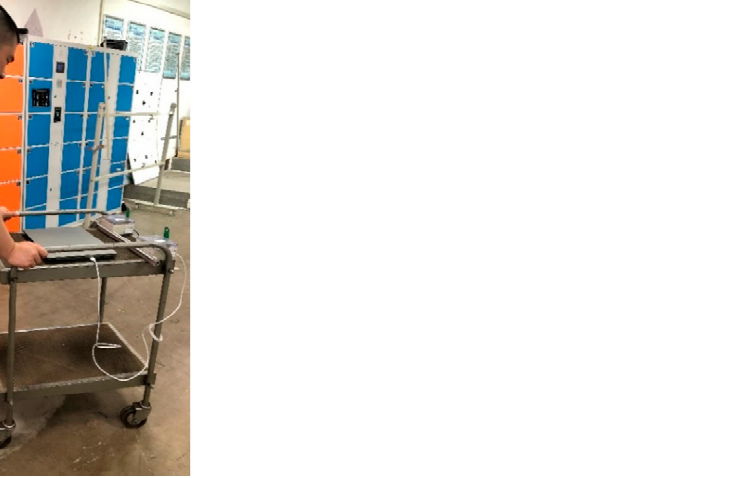
Figure 12. The location of the two rover stations and the trolley in Test 3. The dynamic positioning results of the common methods, DUWB and BC-DUWB, are shown in Figure 13a,b.